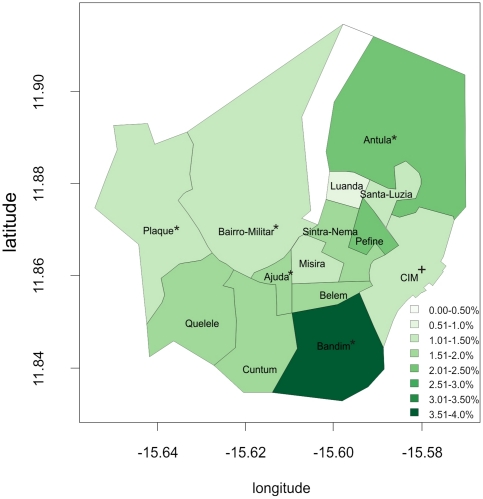
Age and gender adjusted cholera attack rates (%) by Sanitary Area in Sector Autónomo de Bissau, 2008–2009.Coordinates expressed in sexagesimal degrees. * Sanitary area with a cholera treatment centre. + Sanitary area with a cholera treatment unit.